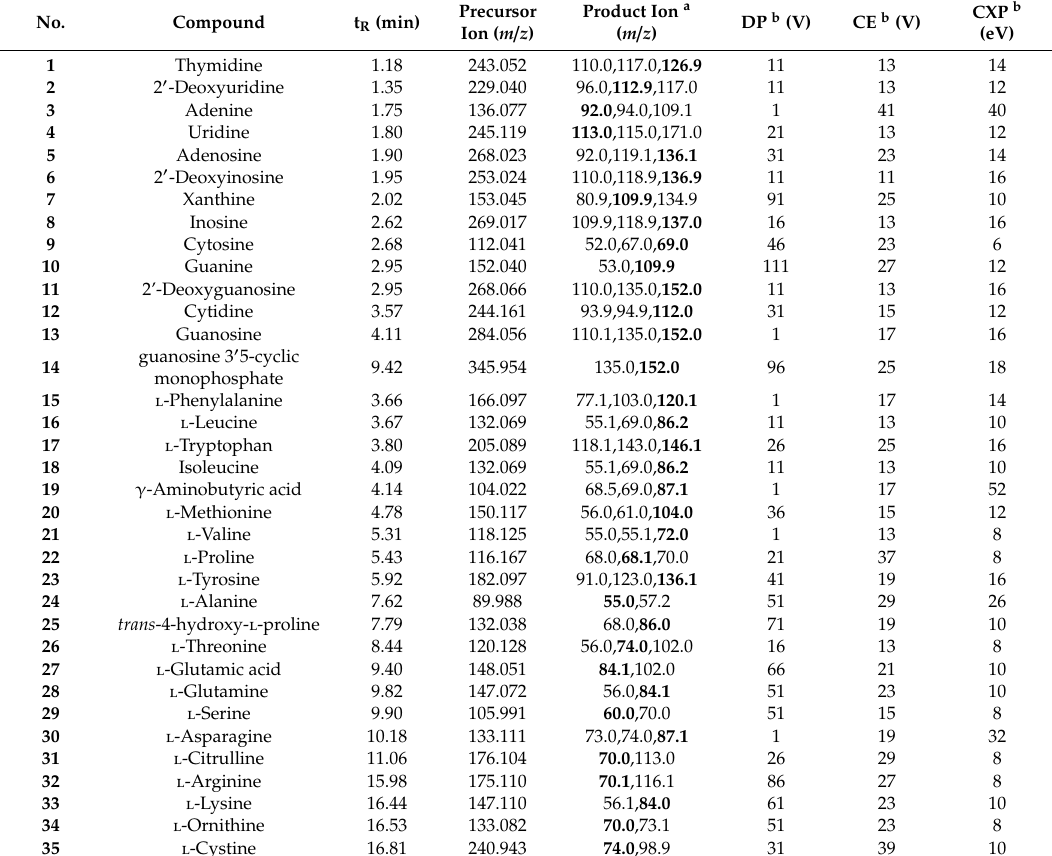
Table 1. Precursor / product ion pairs and parameters for SIM / MRM of compounds used in this study.